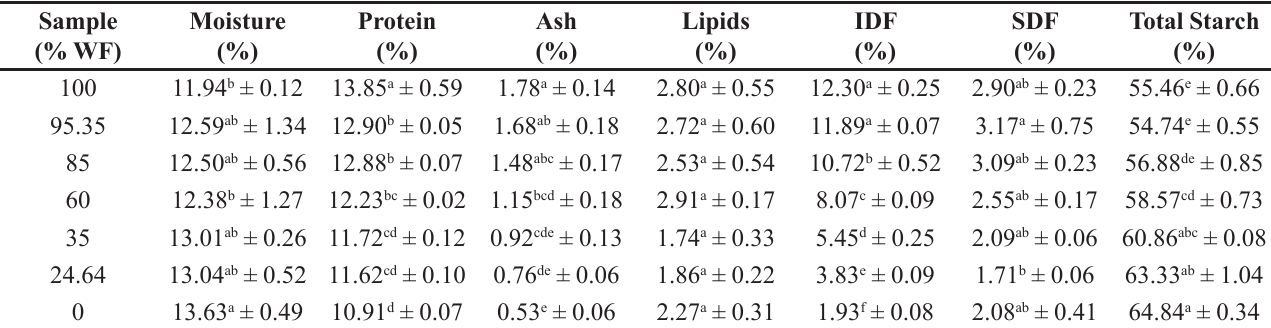
TABLE I - Chemical characterization of flours Sample